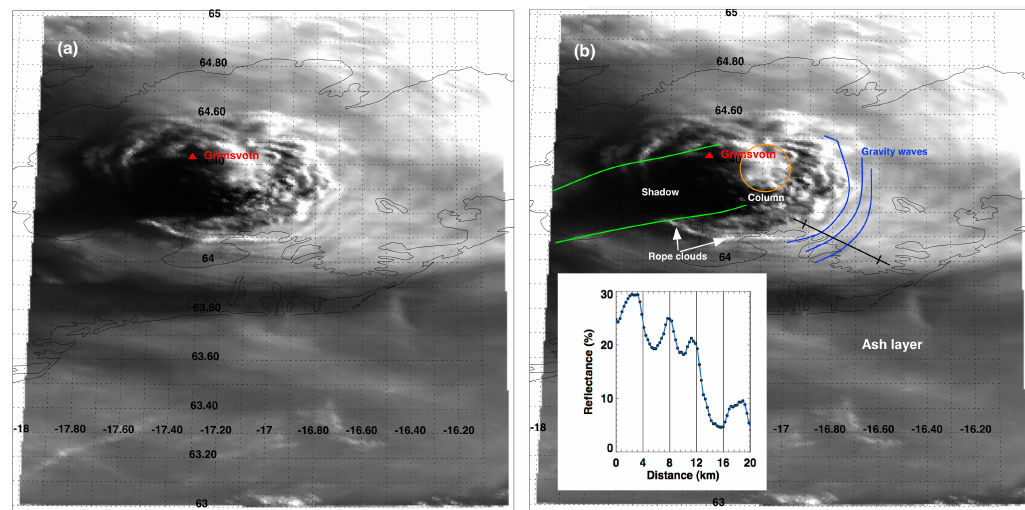
Figure 12. (a) MODIS/Aqua 250m resolution 841–876nm reflectance image showing the Grímsvötn ash column, ash column shadow, ash layer, rope clouds, and gravity wave features. (b) Annotated version of (a) with inset plot showing reflectance along the straight black line from the ash column towards the southeast. The blue-coloured arcs indicate the locations of wave-like fronts. The orange-coloured circle indicates the outline of the ash column, which casts a strong shadow (westwards of the column) on the underlying clouds of ash and water clouds. The apparent wavelength of the waves is ∼ 4–6km. The solar zenith and azimuth and MODIS viewing zenith and azimuth angles close to the column are 82.5, 56.4, 55.5, and − 53.4 ◦ , respectively. Image acquired at 05:15UTC on 22 May